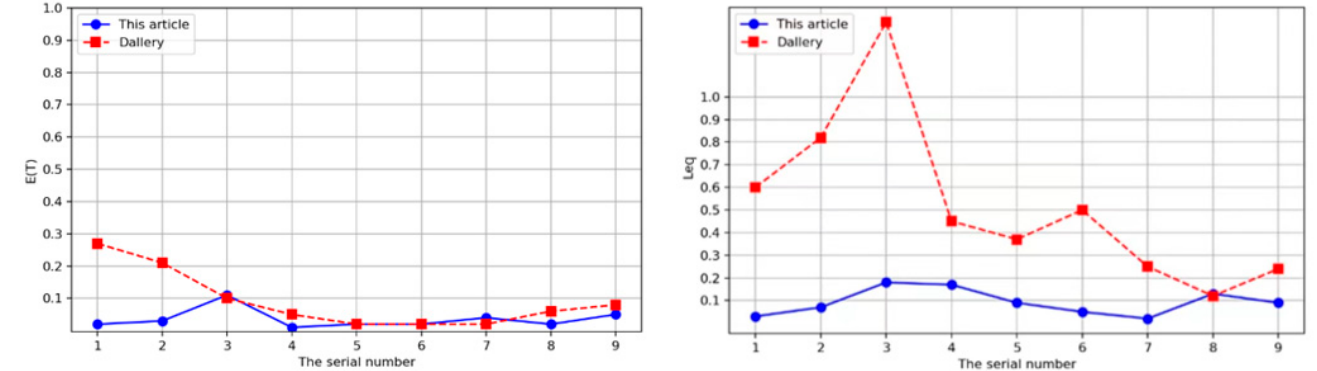
Figure 13. Comparison of system response time E ( T ) , external queue waiting for pair length L eq error under two solving methods.